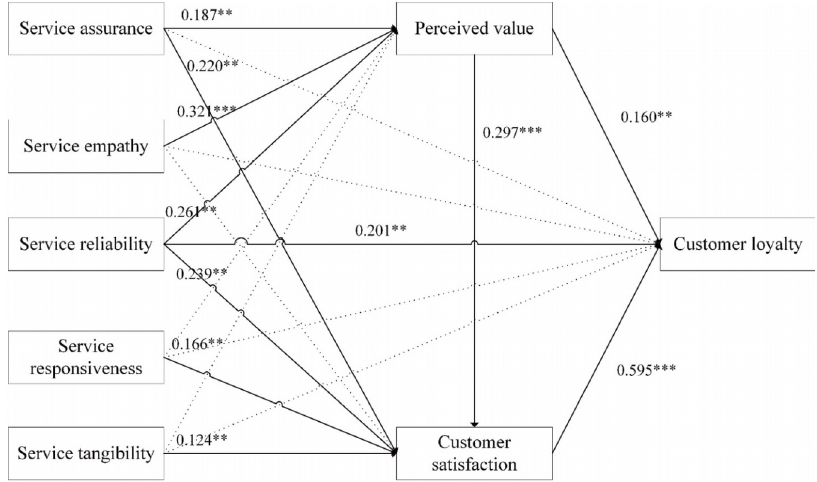
Figure 2. PLS-SEM result of structural equation model with non-discriminated